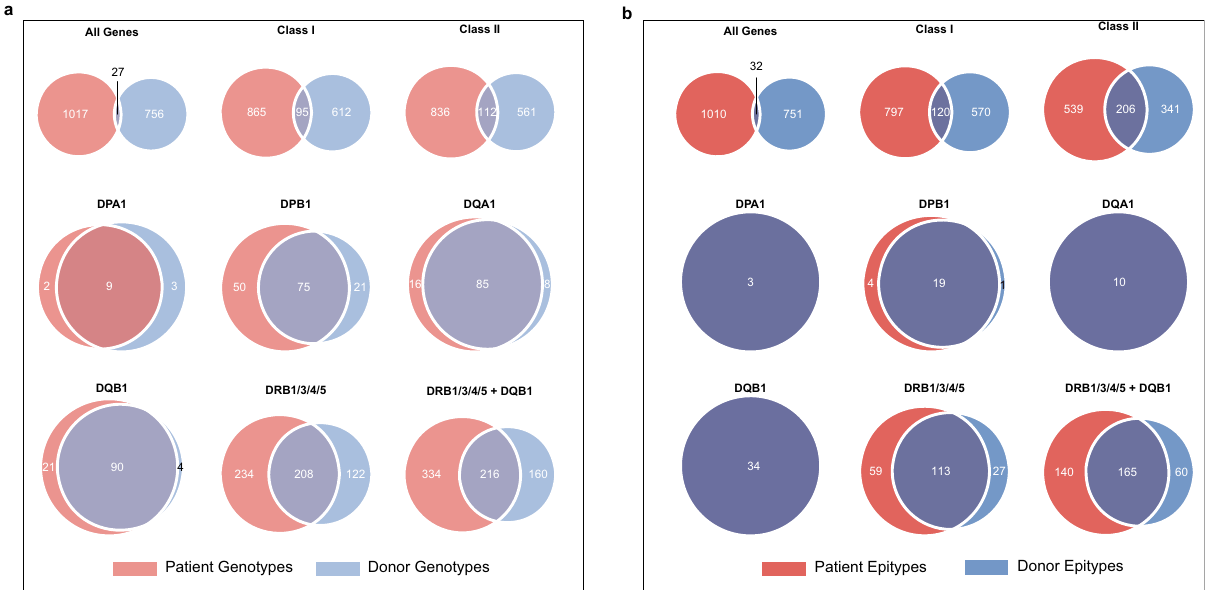
Fig. 6 Genotype and epitype frequencies between patients and donors. a Venn diagrams of unique genotypes and how some or all occur between patients ( n = 1049) and donors ( n = 797). Genotypes were determined at the individual level, where alleles of a particular loci were sorted and combined. Analysis was performed on various loci combinations: all 11 HLA genes, HLA class I, HLA class II, DPA1, DPB1, DQA1, DQB1, DRB1/3/4/5 , and DQB1 and DRB1/3/4/5 combined. b As above but for